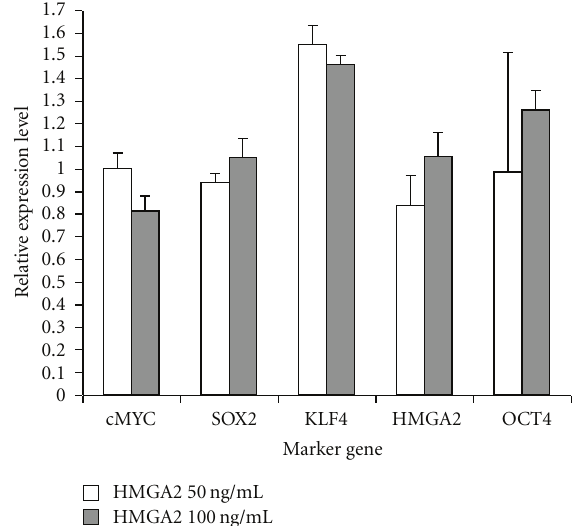
Figure 3: Marker gene expression in HMGA2 protein-stimulated (50, 100 ng/mL) and -unstimulated cASCs (relative expression = 1) after RT-qPCR. HPRT was used as endogenous control. All analysed genes (cMYC, SOX2, KLF4, HMGA2, and OCT4) are expressed in cASCs. No significant marker gene regulation could be detected after HMGA2 application in both